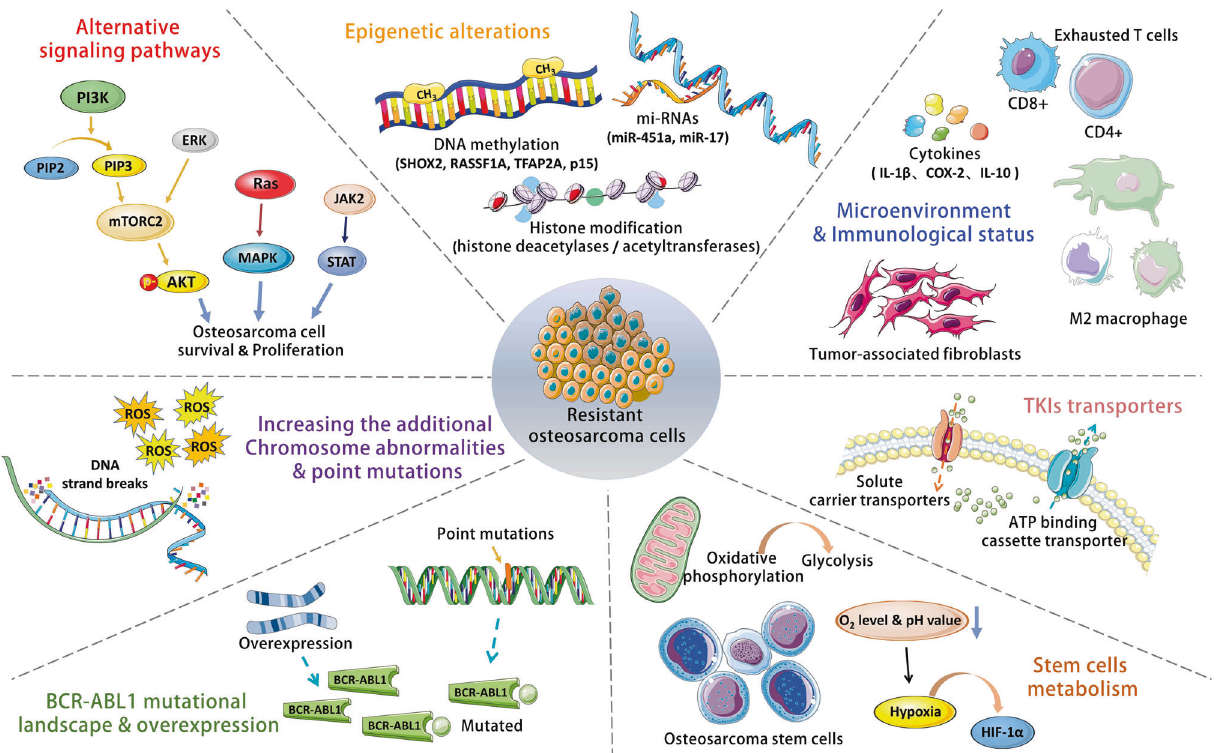
Fig. 5 The common resistance mechanisms of TKIs in tumors. Dysregulation of tyrosine kinase activity is frequently found in tumors, of which the most clinically relevant and most studied is the abnormal expression of BCR-ABL1. BCR-ABL1 mutation was fi rst identi fi ed as a point mutation caused by the substitution of isoleucine for threonine at position 315, which occurs most frequently in drug-resistant patients, and the effectiveness of TKIs is highly dependent on the interaction between BCR-ABL1 and THR, and the failure of TKI binding to the target kinase caused by the overexpression of BCR-ABL1 and fusion gene mutation may lead to drug